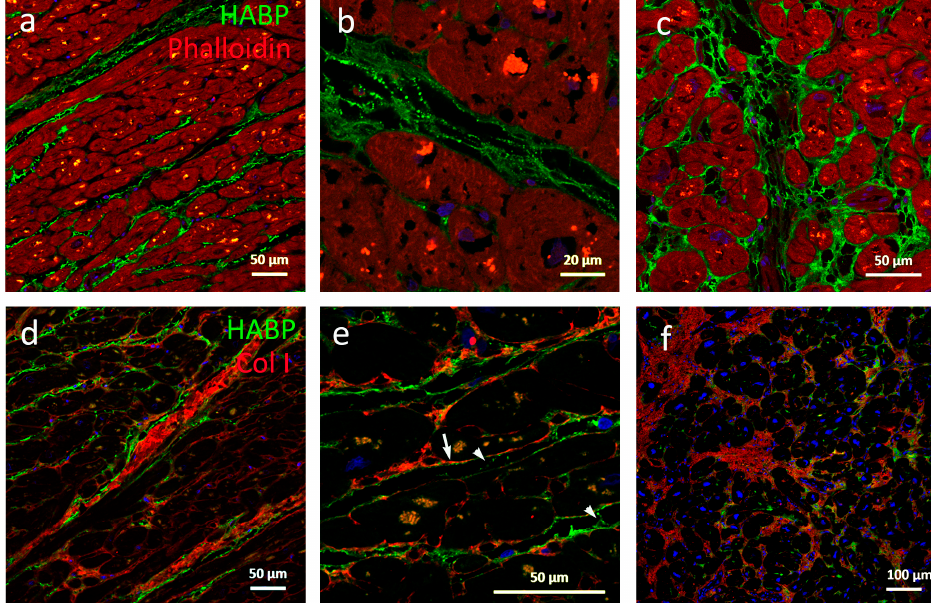
Figure 1. Morphological distribution of HA in cardiac tissue. Cardiomyocytes from non-failing septum (healthy controls) ( a – b , d – e ) n = 5 and HCM ( c , f ) n = 5 . ( a ) In non-failing hearts, HA form long fine fibers in the perimysium running parallel to myofibers. ( b ) Sometimes these fibers are aligned with stained dots of HA forming an appearance of a string of pearls. ( d ) Collagen coil structures are surrounded by, but exclude, HA. ( e ) HA is located immediately adjacent to collagen weaves (arrow), and form strand-like structures between fibers (arrowheads). ( c ) In HCM, individual cardiomyocytes are separated by HA, which is also more abundant regularly filling the perimysium forming large patches with enlarged ring-like structures. ( f ) In areas with expanded ECM with fibrosis, there were patches where collagen and HA were mutually excluded. Hyaluronan binding protein (HABP, green), cardiomyocytes (phalloidin, red), nuclei (Hoechst, blue) ( a – c ). Hyaluronan binding protein (HABP, green), collagen I (Col I, red), nuclei (Hoechst, blue) ( d – f ). Large pale red dots inside cells are artefacts due to auto